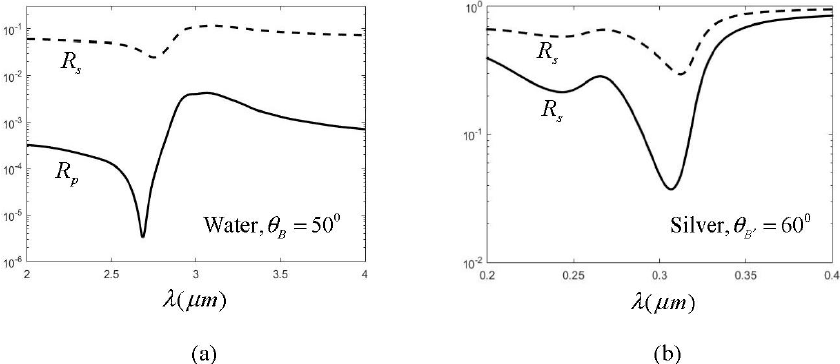
Figure 7. ( a ) The reflectance of R s (λ) and R p (λ) of water; ( b ) The reflectance of R s (λ) and R p (λ) of Ag.